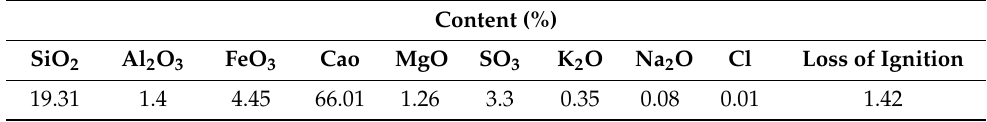
Table 1. Chemical properties of cement. CEM I